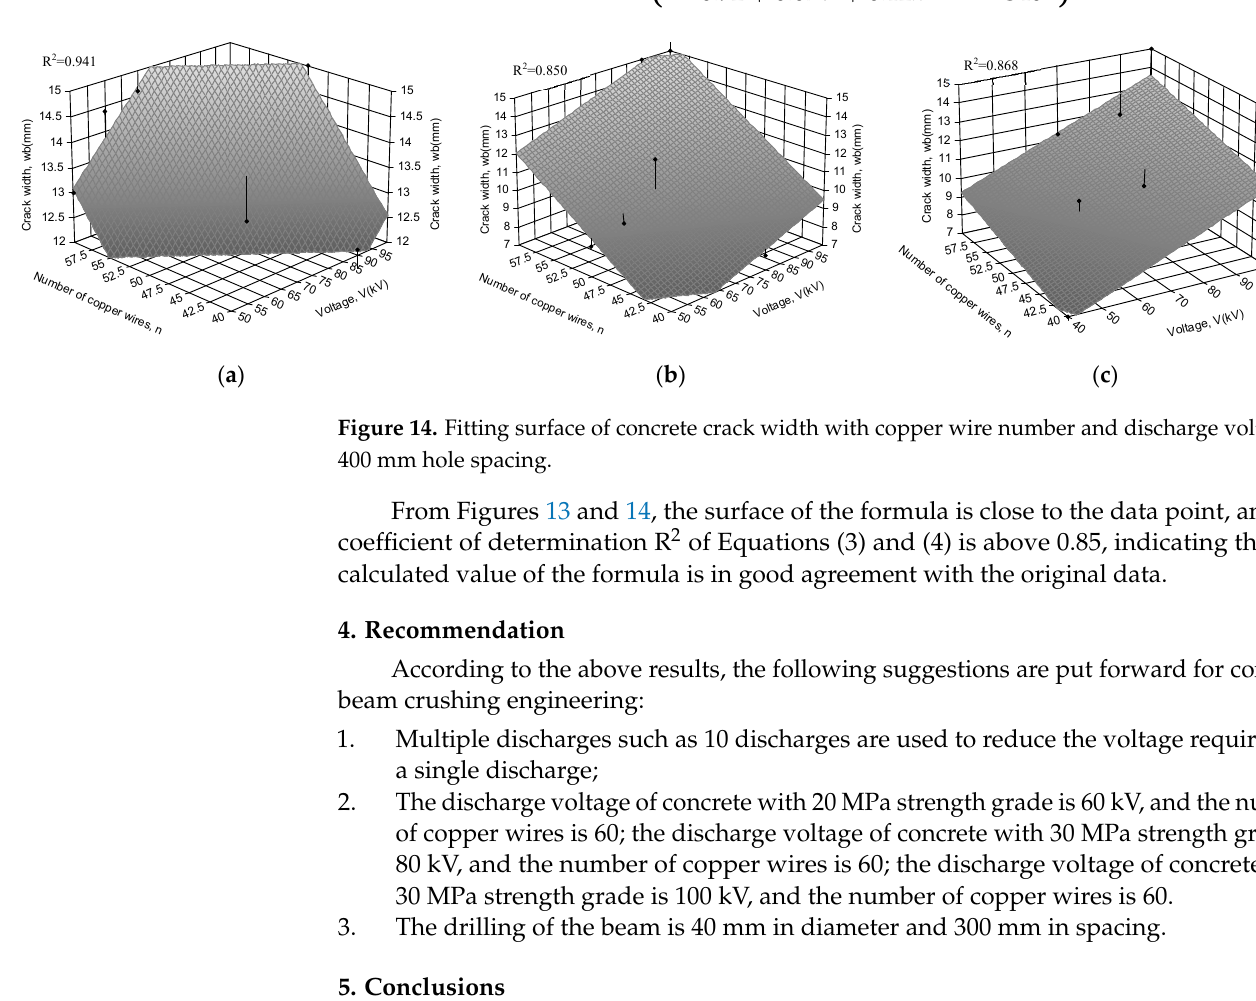
Figure 13. Fitting surface of concrete crack width with copper wire number and discharge voltage at 300 mm hole spacing. ( a ) Concrete C20; ( b ) Concrete C30; ( c ) Concrete C40.